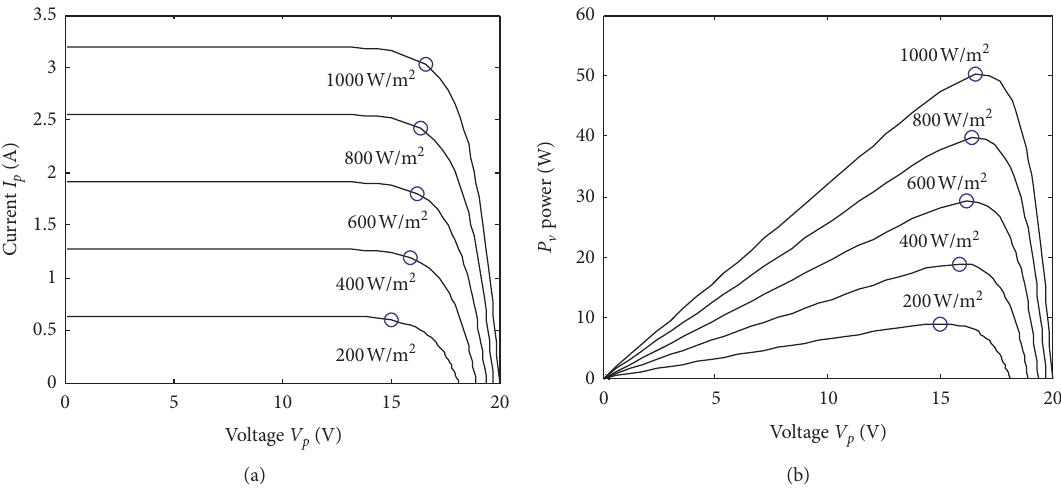
Figure 4: Output characteristics of a PV panel with solar radiation.